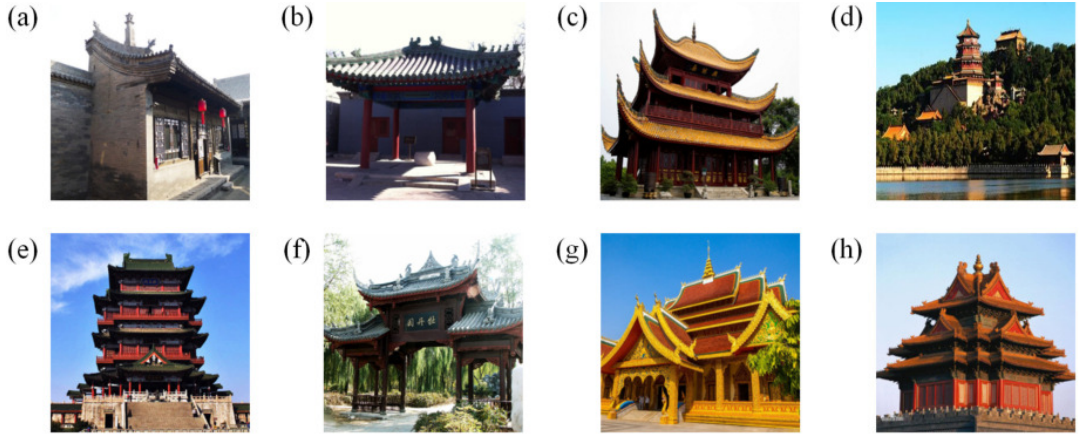
Figure 6. Derived transformation of semantic components. ( a ) Single-slope roof; ( b ) lu-roof; ( c ) helmet roof; ( d ) skyline of the Summer Palace with multiple buildings; ( e ) multiple roofs with a multi-story building; ( f ) decorated archway; ( g ) multiple roofs with a single building; ( h ) cross roofs with a single